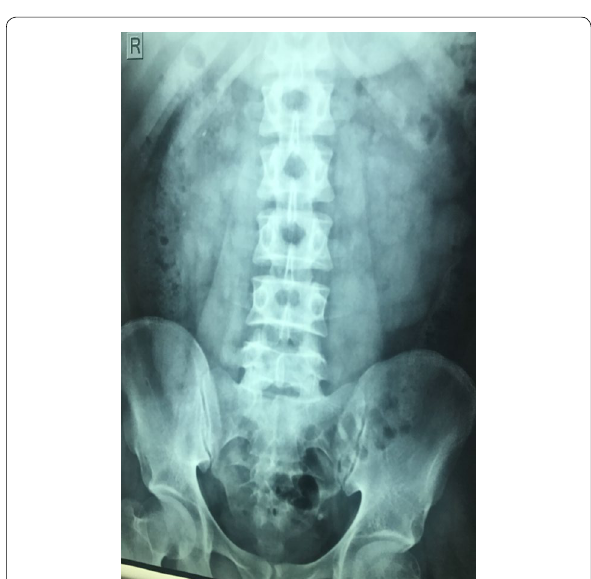
Fig. 4 Post ESWL stone migrated or pushed to the left lower